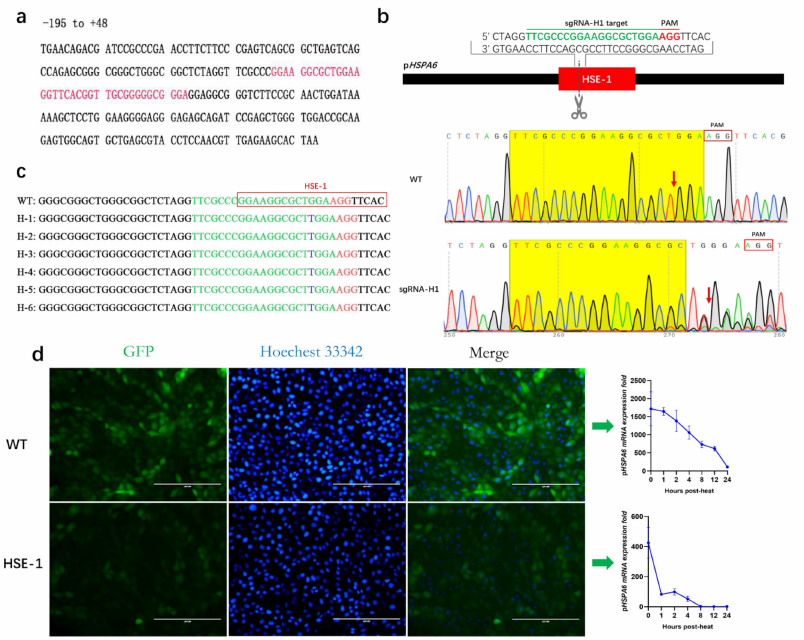
Figure 2. Effect of HSE-1 on the expression of p HSPA6 . ( a ) The position of HSE-1 was located in the p HSPA6 promoter. ( b ) Strategy of sgRNA-H1 knock-in into p HSPA6 ; the cutting efficiency of sgRNA- H1 was evaluated using chromatograms. Red blocks and red arrows represent PAMs and cleavage sites, respectively. ( c ) Diagram of positive clone HSE-1 after pLB vector cloning. ( d ) Fluorescence microscopy and qPCR analysis of p HSPA6 expression in WT and positive clone cells (data show the mean ± S.E.M. in triplicate